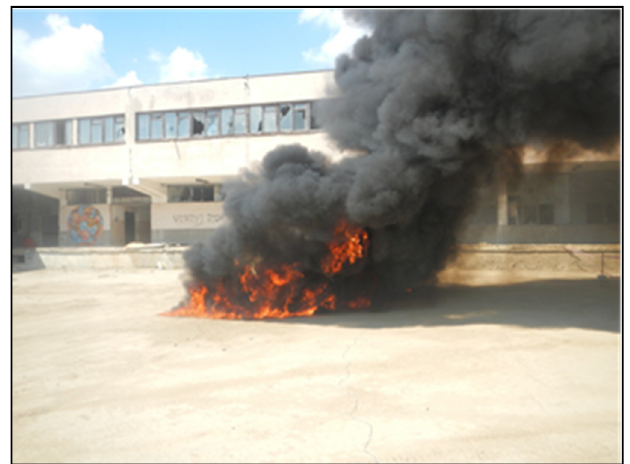
Figure 14. Fire of the 20 L gasoline on dense concrete pavement 15 s after ignition.